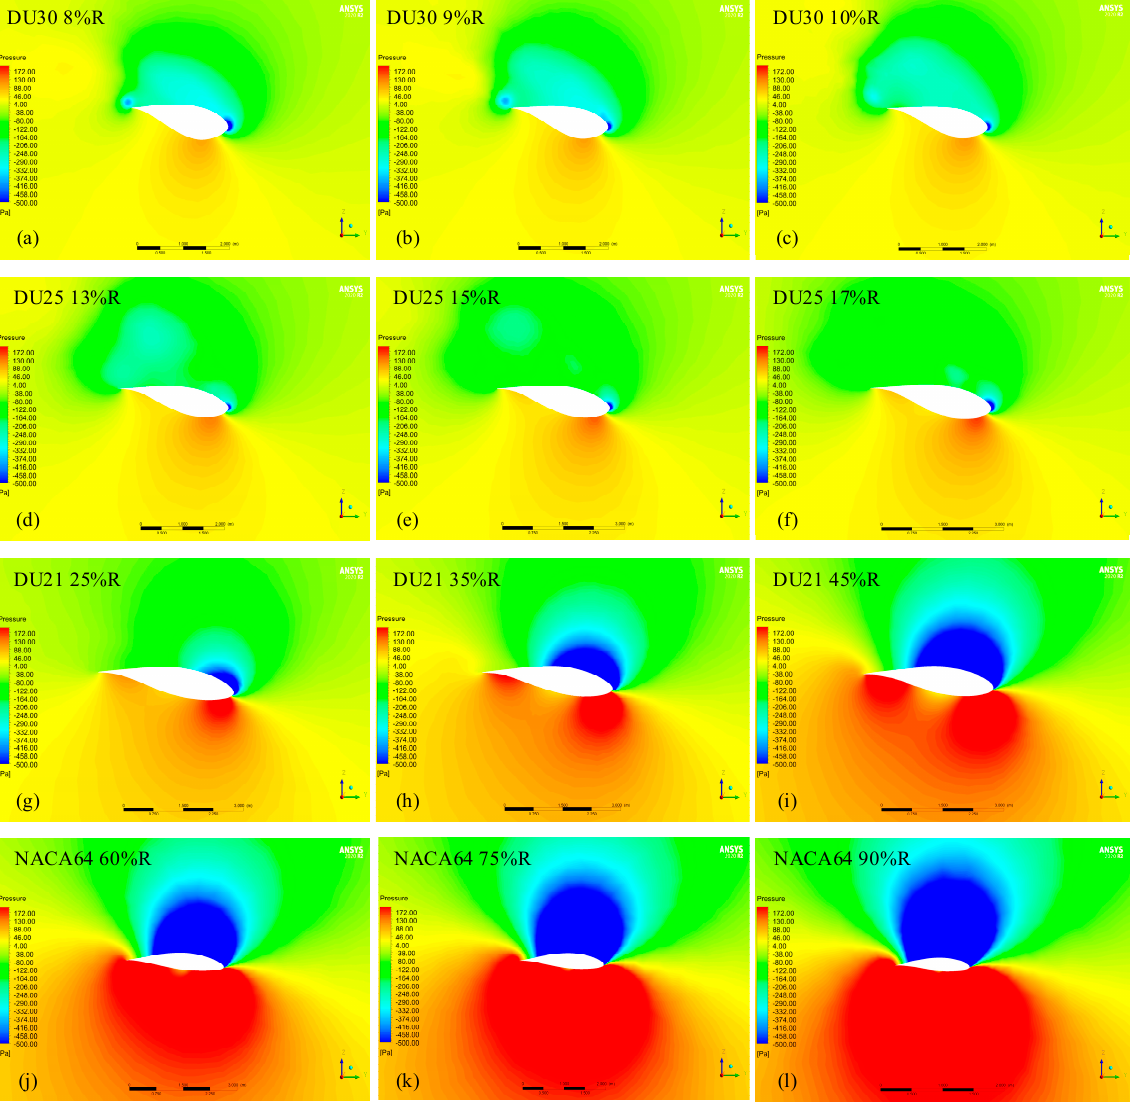
Figure 15. Pressure cloud maps at different sections of the Two − BWT blade. ( a ) At 8% R section; ( b ) At 9%R section; ( c ) At 10%R section; ( d ) At 13%R section; ( e ) At 15%R section; ( f ) At 17%R section; ( g ) At 25%R section; ( h ) At 35%R section; ( i ) At 45%R section; ( j ) At 60%R section; ( k ) At 75%R section; ( l ) At 90%R section.